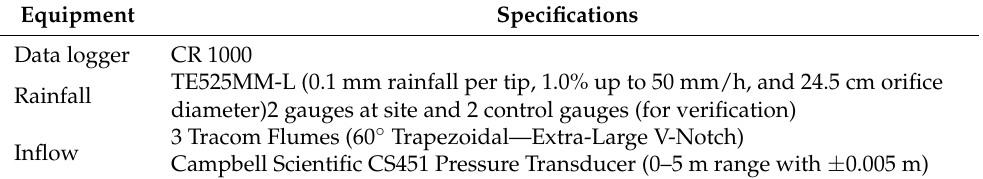
Table 2. Monitoring setup at